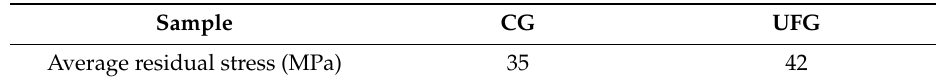
Table 2. Residual stress of the Cu-Cr-Zr alloy after aging. CG: coarse-grained; UFG: ultrafine-grained.